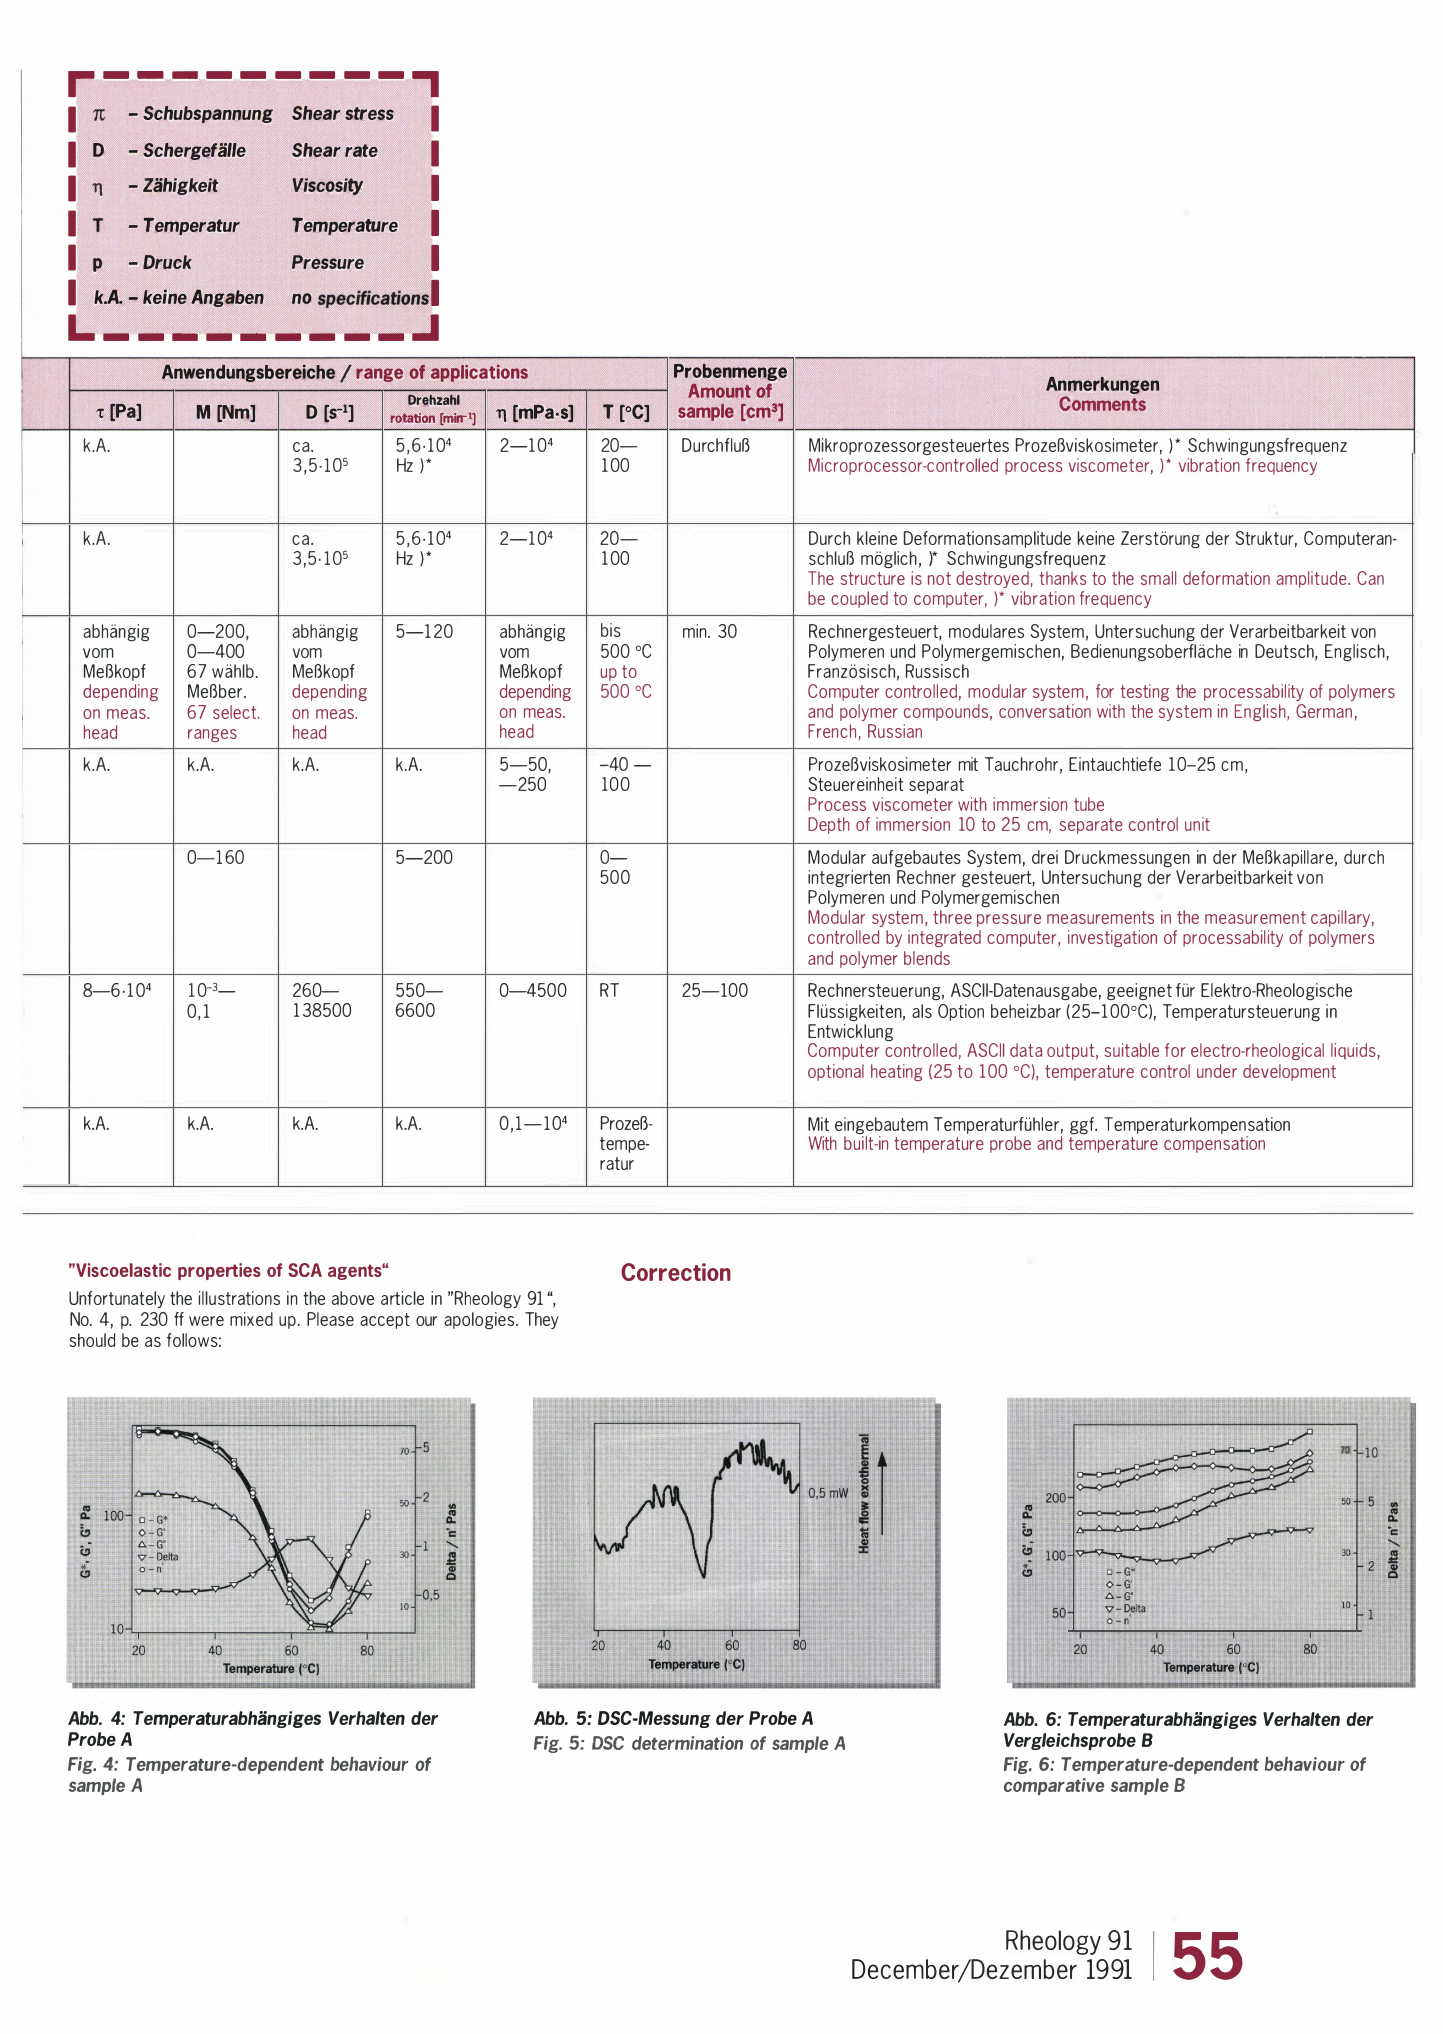
Abb. 6: Temperaturabhiingiges Verhalten der Vergleichsprobe B Fig